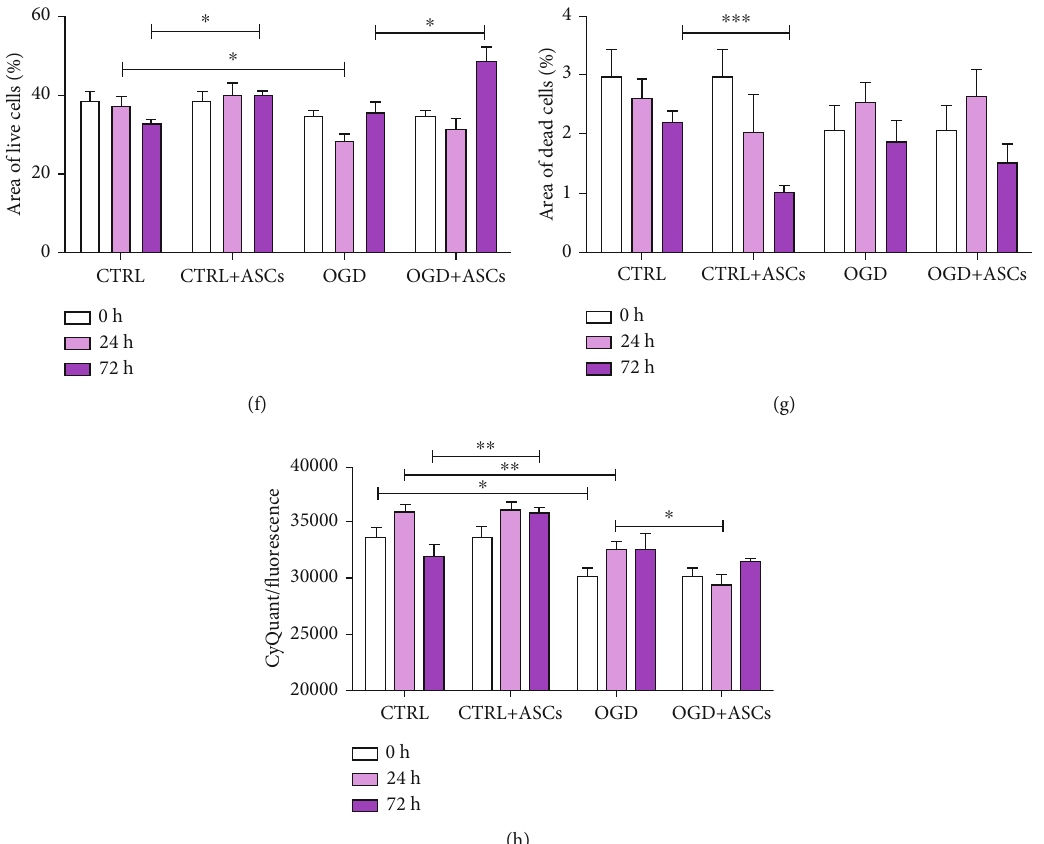
Figure 3: Cell viability and cytotoxicity of SH-SY5Y- and hiPSC-neurons after OGD and ASC coculture. (a, e) Representative images of live/dead staining after 72h of reperfusion in SH-SY5Y-neurons (a) and hiPSC-neurons (e). Green =live cells/calcein-AM; red =dead cells/EthD-1. Scale bar, 100 μ m. (b) Area of live SH-SY5Y-neurons and (f) hiPSC-neurons. (c – g) Area of dead SH-SY5Y-neurons (c) and (g) hiPSC-neurons. For quanti fi cation of live and dead cells, images were analyzed from two to three wells/group, and four images were taken from each well (one experiment for SH-SY5Y-neurons and representative data of two separate experiments for hiPSC-neurons). (d) Analysis (CyQuant) of the number of SH-SY5Y-neurons ( n = 3 /group, data from four independent experiments) and (h) hiPSC-neurons ( n = 3 /group, representative data of two separate experiments). All statistical analyses were performed using an independent t -test, statistical signi fi cance: ∗∗∗ p < 0 : 001 , ∗∗ p < 0 : 01 , and ∗ p < 0 : 05 . All quantitative data are presented as the mean ± SEM